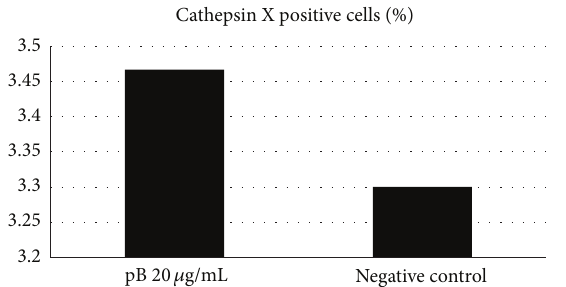
Figure 1: Expression of cathepsin X on THP-1 cells after stimulation with polymyxin B (pB) and when antigens of H. pylori were not added to THP-1 cells (negative